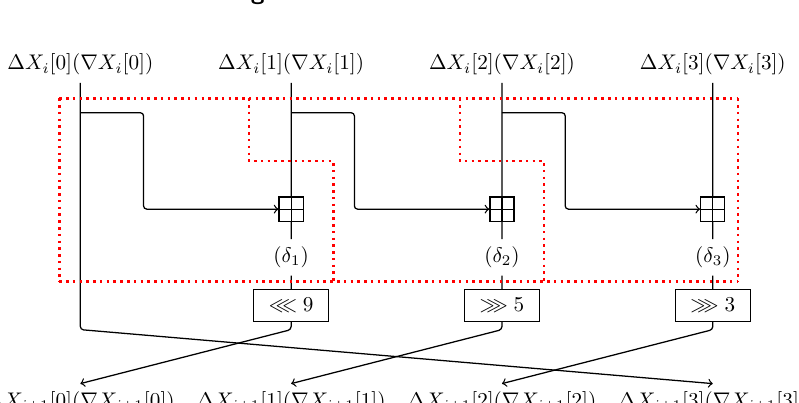
Figure 6: LEA round function.